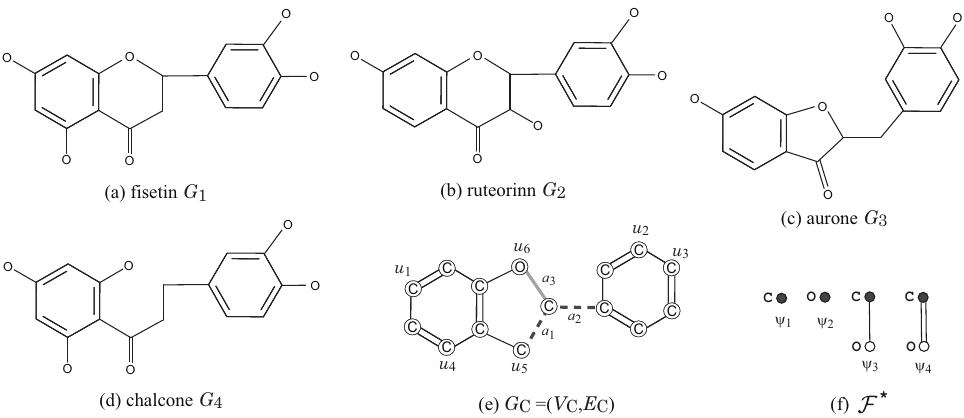
Figure 7. Illustration of a set G ∗ = { G 1 , G 2 , G 3 , G 4 } of four flavonoids, a seed graph G C , and a set F ∗ = { ψ } of chemical rooted trees for ρ = 2: ( a ) fisetin G 1 , ψ 2 , ψ 3 , ψ 4 ( d ) chalcone G 4 ; ( e ) G C = ( V C , E C ) ; ( f ) F ∗ = F E ∪ (cid:83) v ∈ V